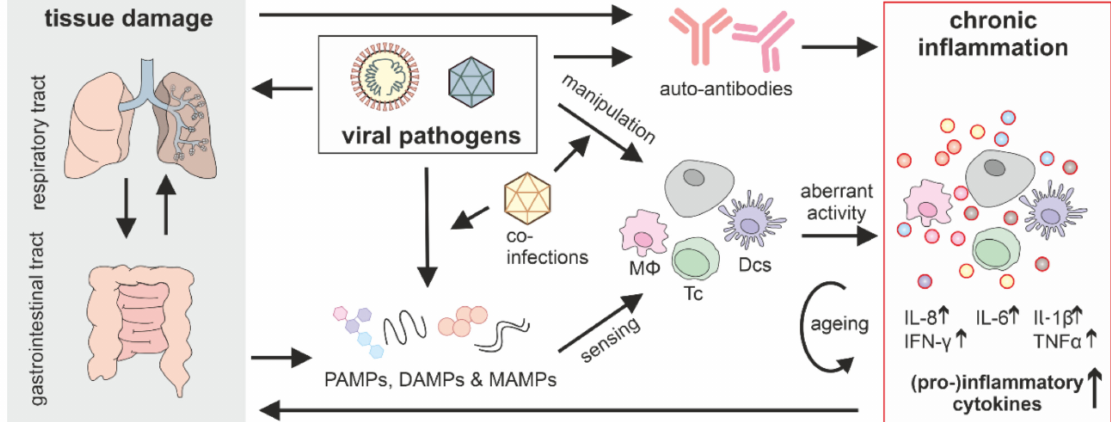
Figure 2. The complex development and amplification of chronic inflammation after an acute viral infection. Viruses trigger the innate immune sensors by PAMPs, but also manipulate the signaling pathways to negate the anti-viral effects of innate immune activation. In addition, many viral pathogens cause tissue damage (grey box), leading to commensal infiltration and further innate immune activation via DAMPs or MAMPs. Dysregulation of immune pathways by viruses, auto-antigen mimicry and tissue damage facilitate the induction of auto-antibodies. Eventually, all these factors cause aberrant activation of immune cells and normal cells leading to (chronic) secretion of inflammatory cytokines. Co-infections further fuel and amplify imbalancing of innate immunity by providing PAMPs but also manipulating cellular signaling cascades. The aberrant activity is further amplified by immune ageing. M Φ , macrophages; Tc, T cells; DCs, dendritic cells; non-immune cells